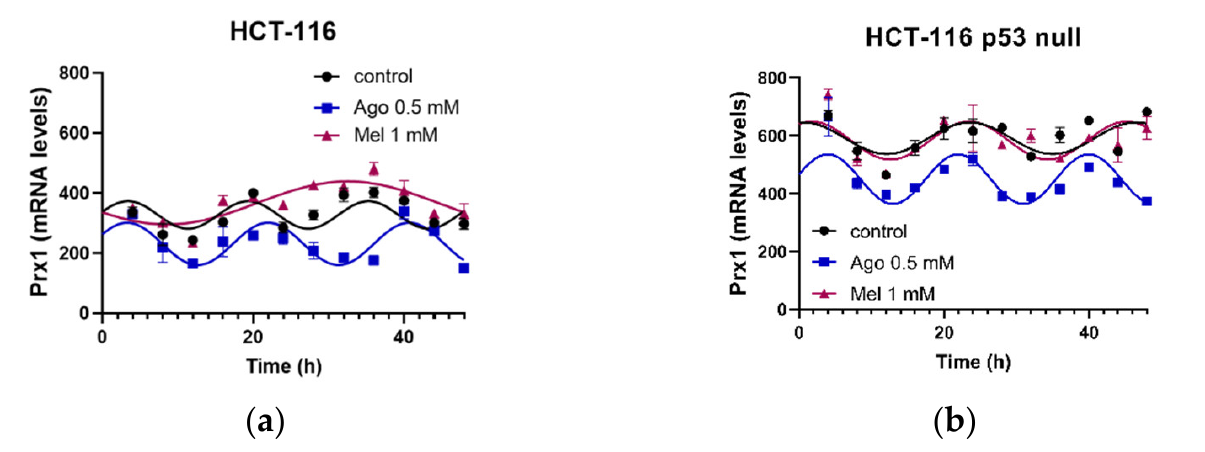
Figure 8. Circadian rhythms obtained for peroxiredoxin 1 (PRX1) gene after agomelatine (Ago) and melatonin (Mel) treatments in the HCT-116 ( a ) and HCT-116-p53-null ( b ) cell lines. Curve fittings under the different conditions were performed using a 48-h test period. Table 4. Results of the cosinor analysis of PEX1-gene expression after agomelatine or melatonin treatment in the HCT-116 and HCT-116-p53-null cell lines.